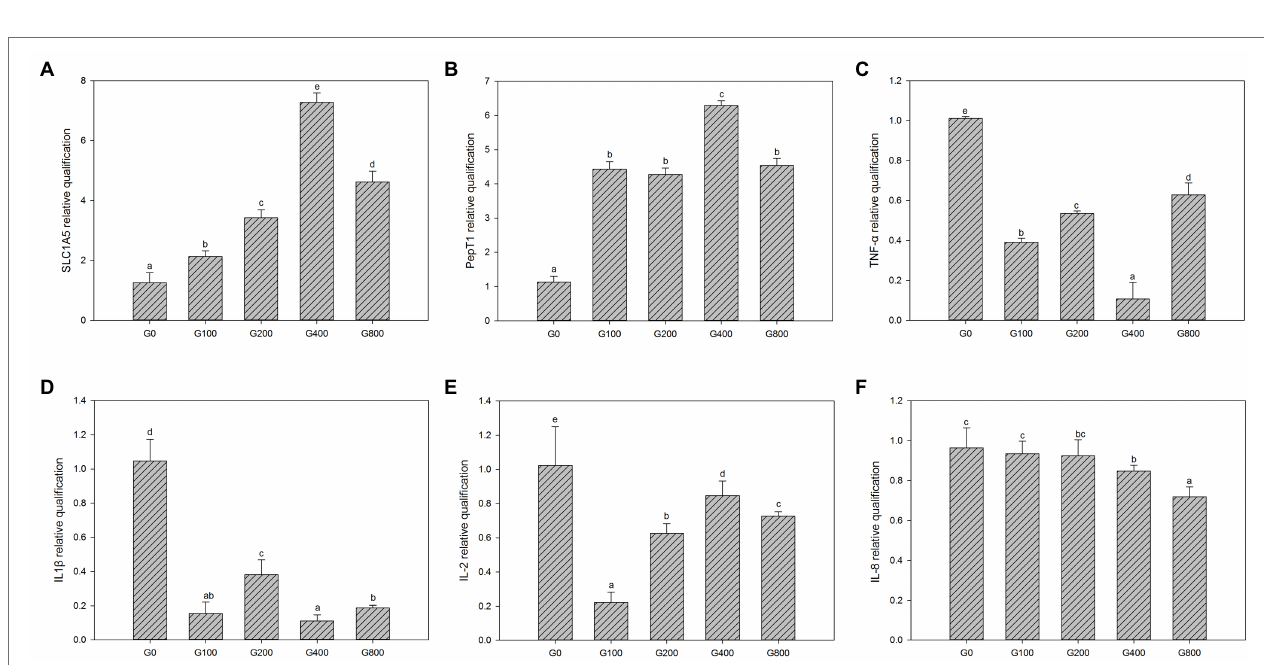
FIGURE 3 | The gene expression of the intestine in each group (mean ± SD, n = 3). (A) SLC1A5, (B) pepT1, (C) TNF- α , (D) IL-1 β , (E) IL-2, and (F) IL-8 [ β -actin was chosen as a reference gene to normalize the results, different letters indicate significant differences between the different groups ( p <